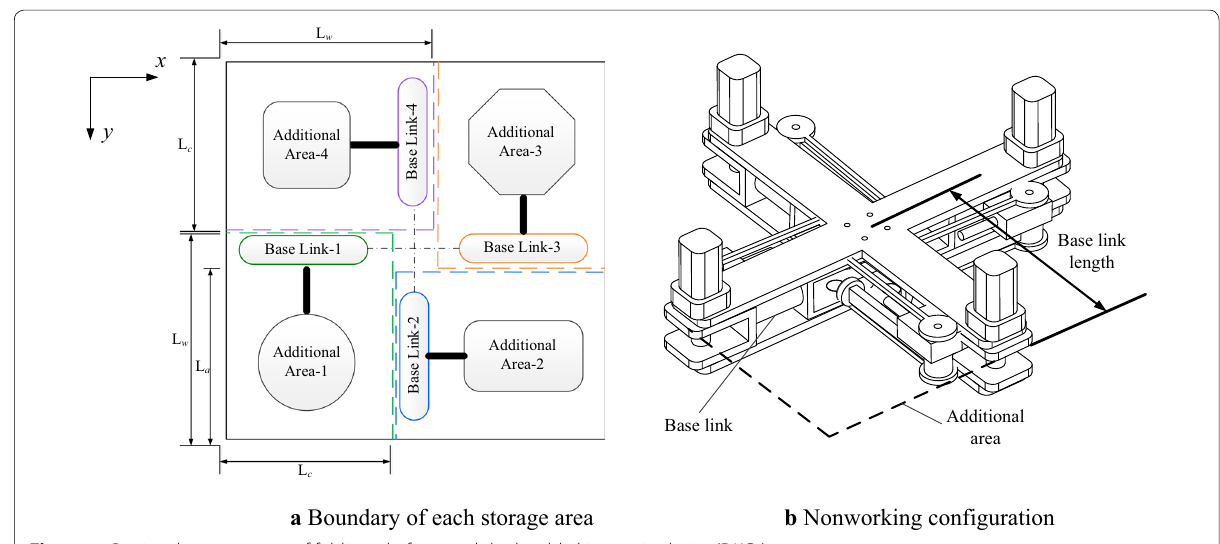
Figure 5 Regional arrangement of folding platform and deployable kinematic chains (DKCs)